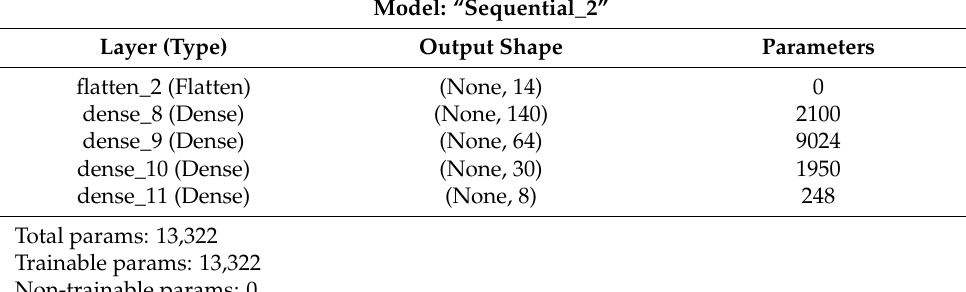
Table 9. TModel2